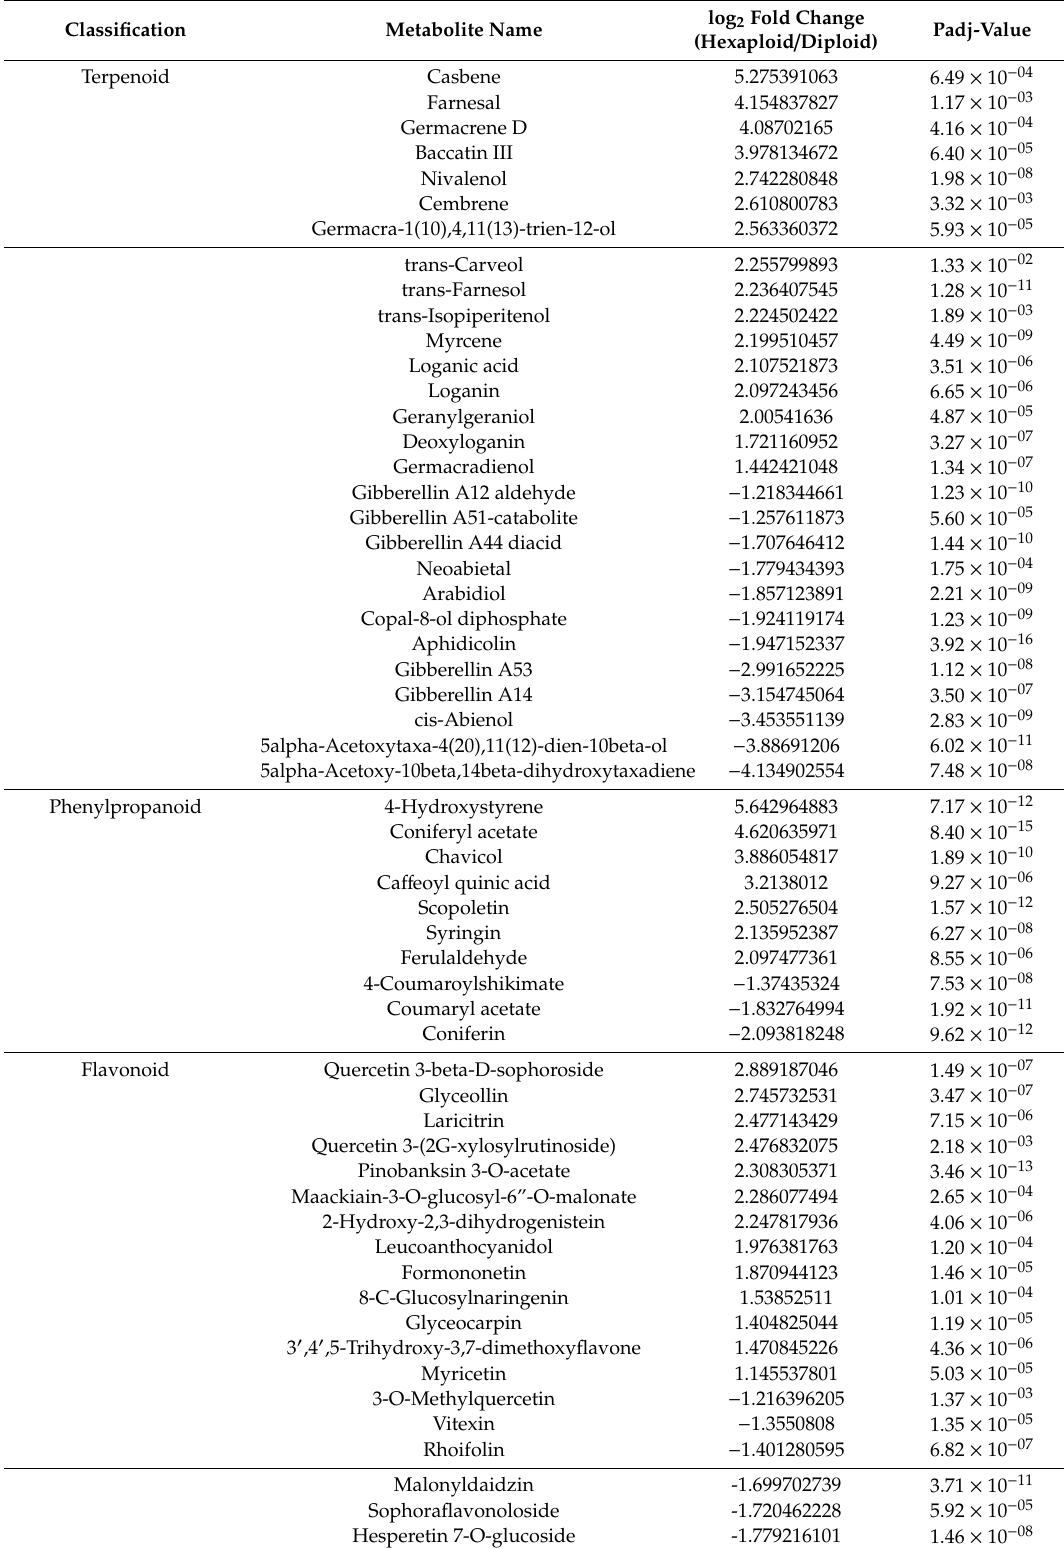
Table 1. Di ff erentially accumulated secondary metabolites between two cytotypes S. canadensis root.